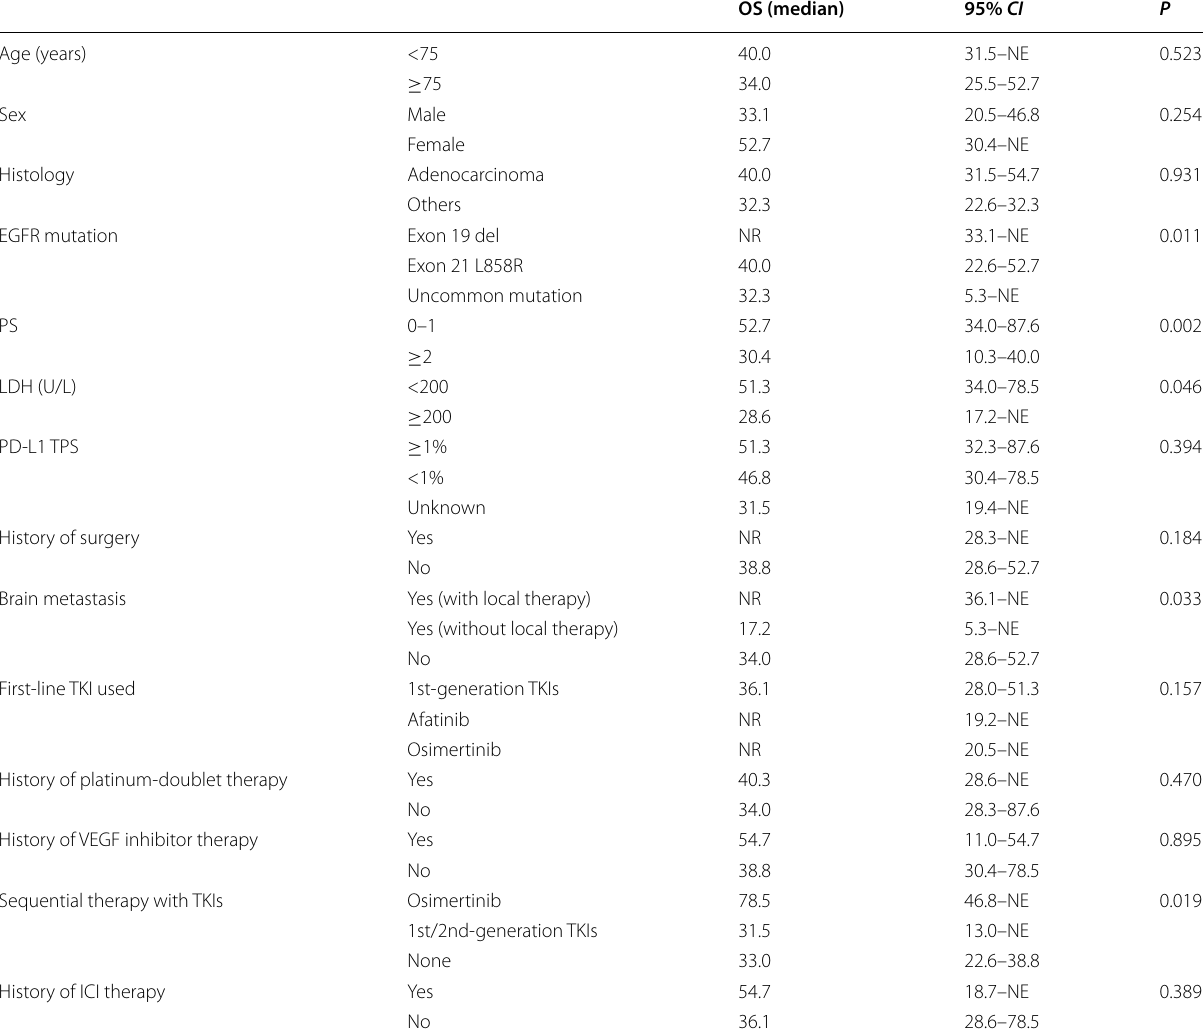
Table 2 Associations of the patient characteristics with the OS (log-rank